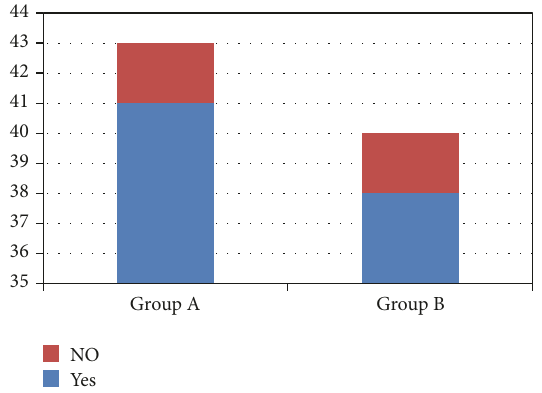
Figure 3: The convenience of the patients to take part in the